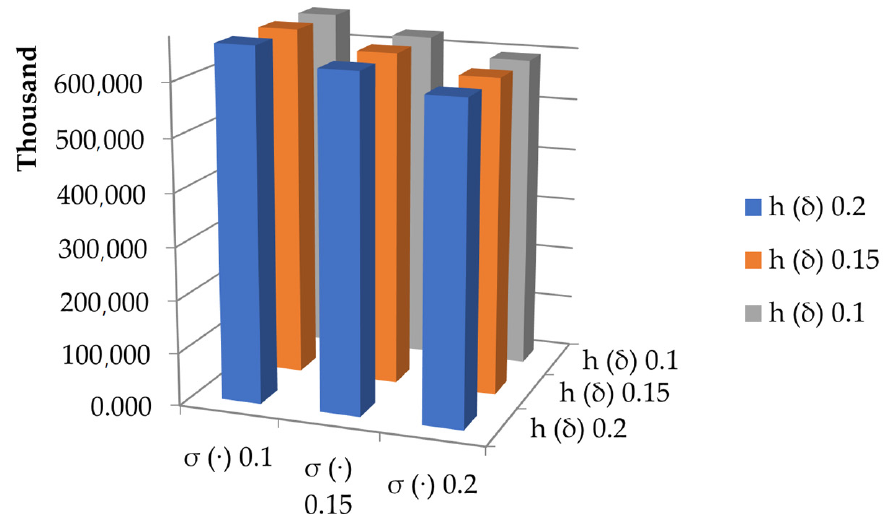
Table 7. Correlation of the Subordinate’s objective functional and the Principal’s objective func- tional using B.I.M. with the same parameters of the reward and penalty system.